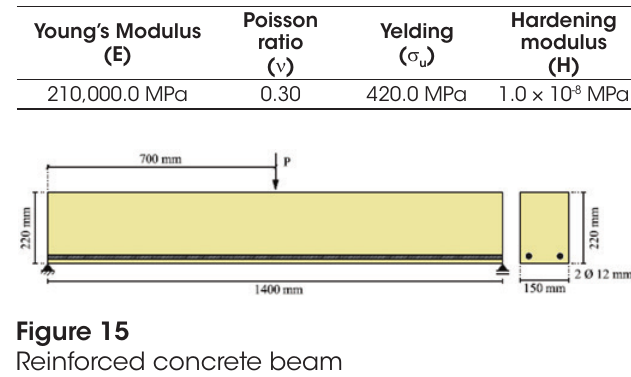
Reinforced concrete beam: material parameters